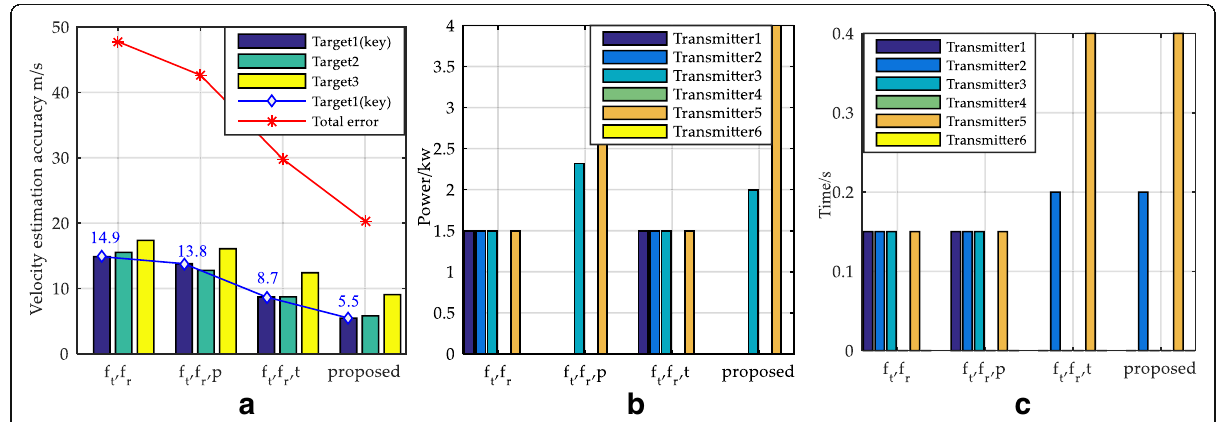
Fig. 3 Experimental results with MSE = [inf, 10 2 , inf]m 2 /s 2 . a Velocity estimation accuracy. b Power allocation results. c Time allocation